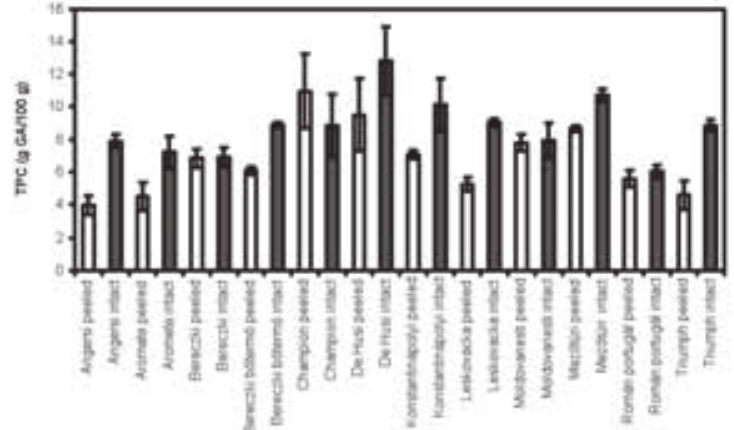
Figure 2 Total phenolics content in peeled (white columns) and intact (grey columns) fruits of Cydonia oblonga genotypes harvested in 2010, Újfehértó,